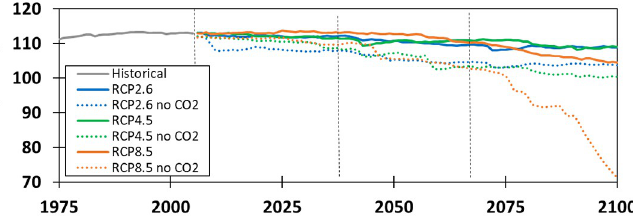
Fig 6. Time series of modelled soil organic carbon (SOC) stocks modelled under RCP 2.6, RCP 4.5 and RCP 8.5 with and without CO 2 fertilization for the grazed